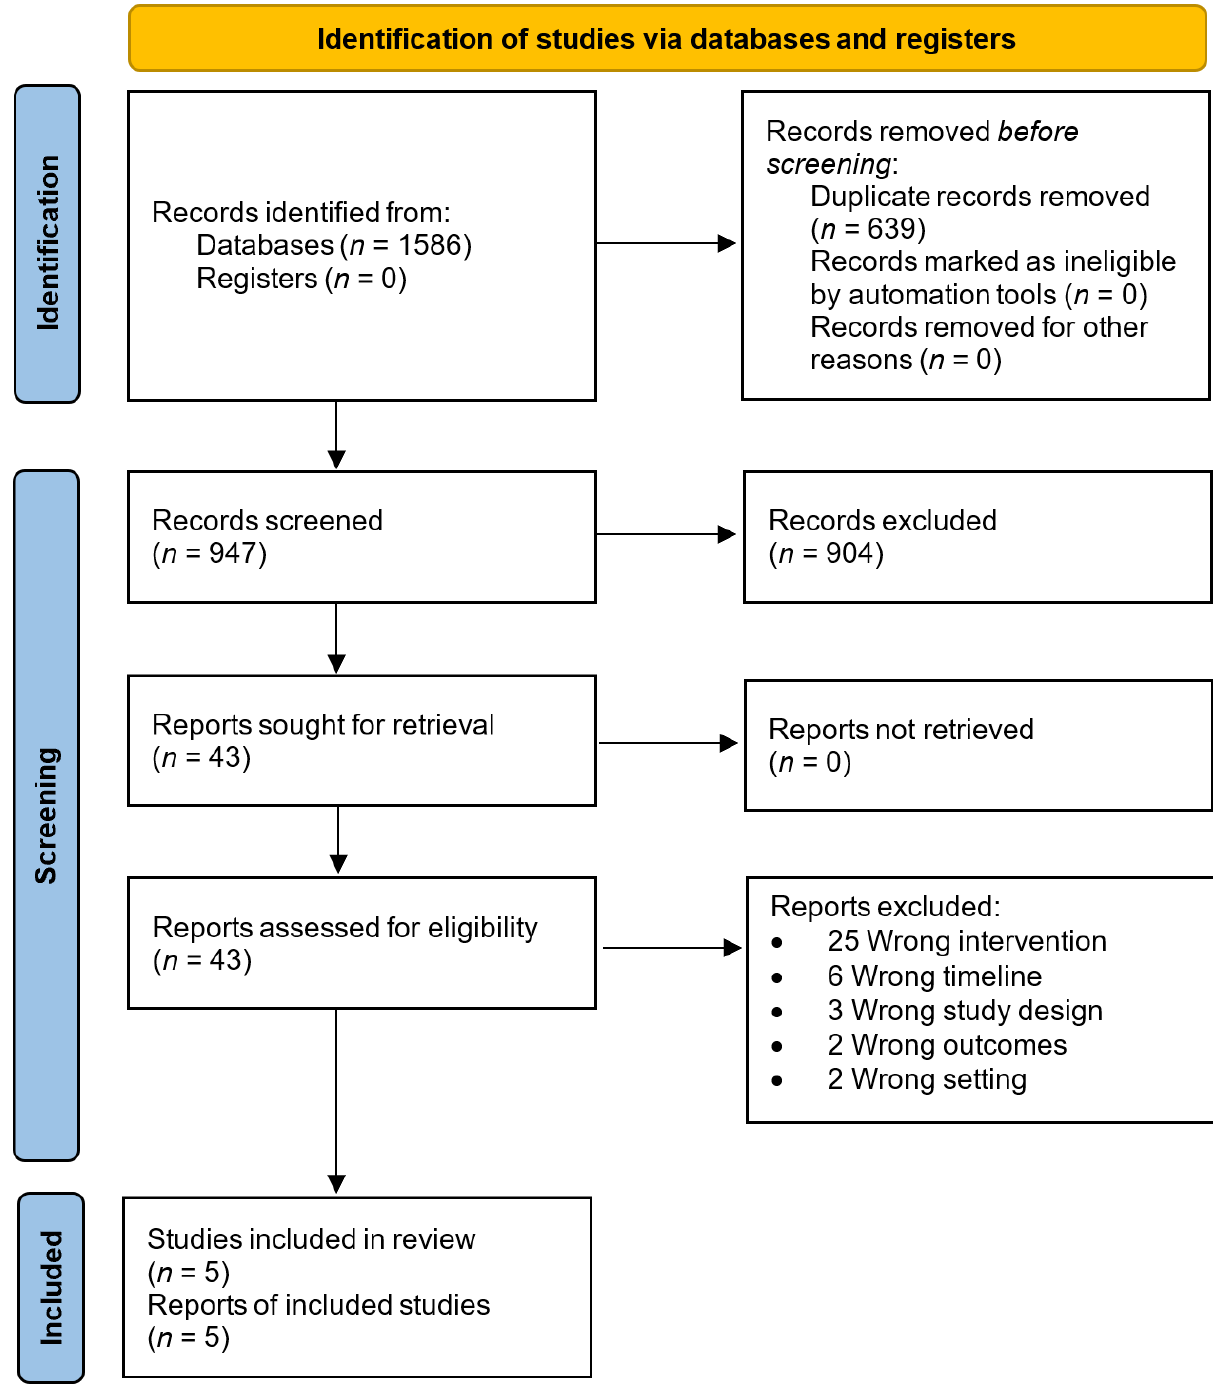
Figure 1. The PRISMA flow diagram of studies in the review.